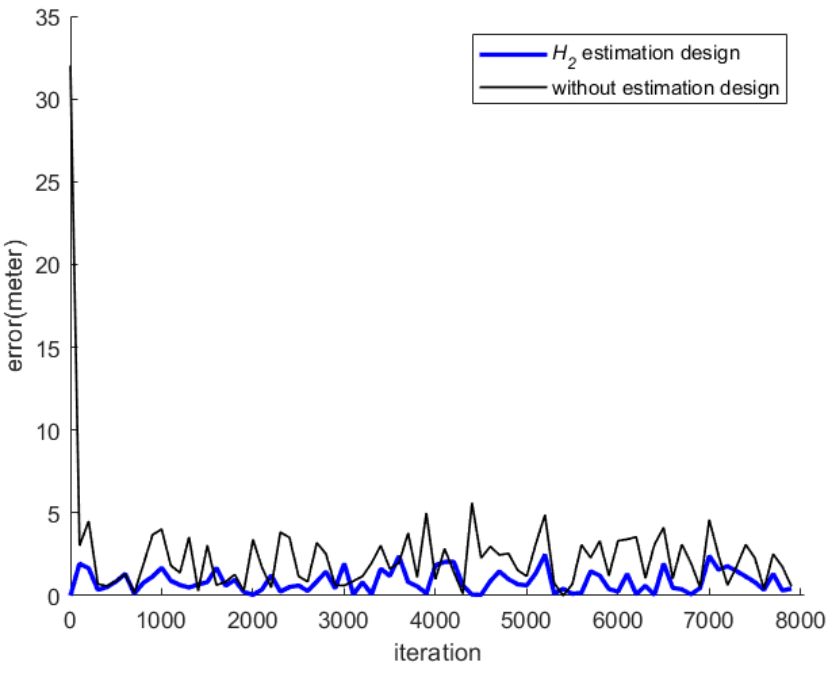
Figure 10. Histories of positioning errors of the proposed estimation design with respect to the positioning scheme without using any estimation design (simulation).